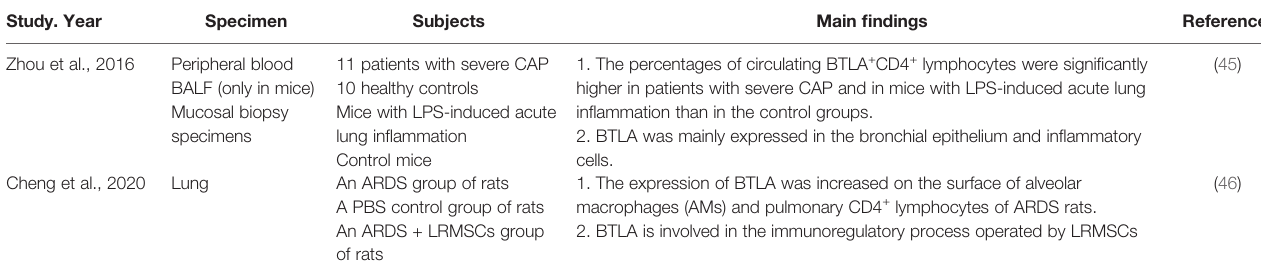
TABLE 4 | The function of BTLA in severe CAP and